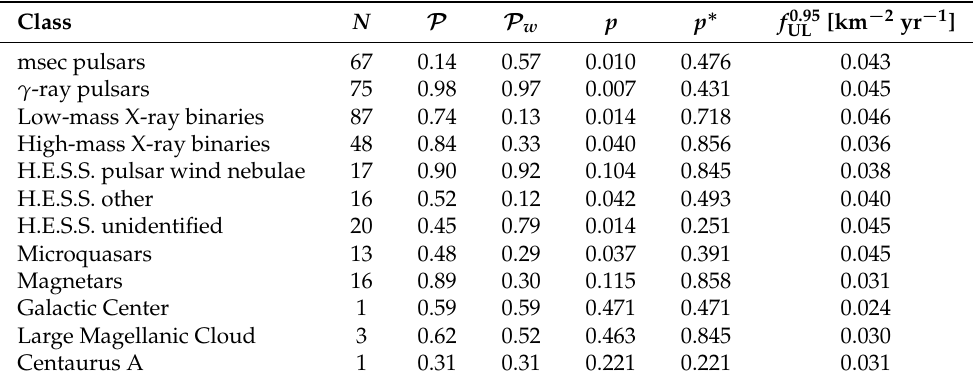
Table 2. Combined unweighted probabilities P and weighted probabilities P w for the 12 target sets analyzed in [43]. In addition, selected information on the most significant target from each target set is given: the unpenalized ( p ) and penalized ( p ∗ ) p -values and the derived upper limit on the photon flux at 95% C.L.. More details on the most significant targets, e.g., the galactic coordinates and upper limits on the energy flux, can be found in